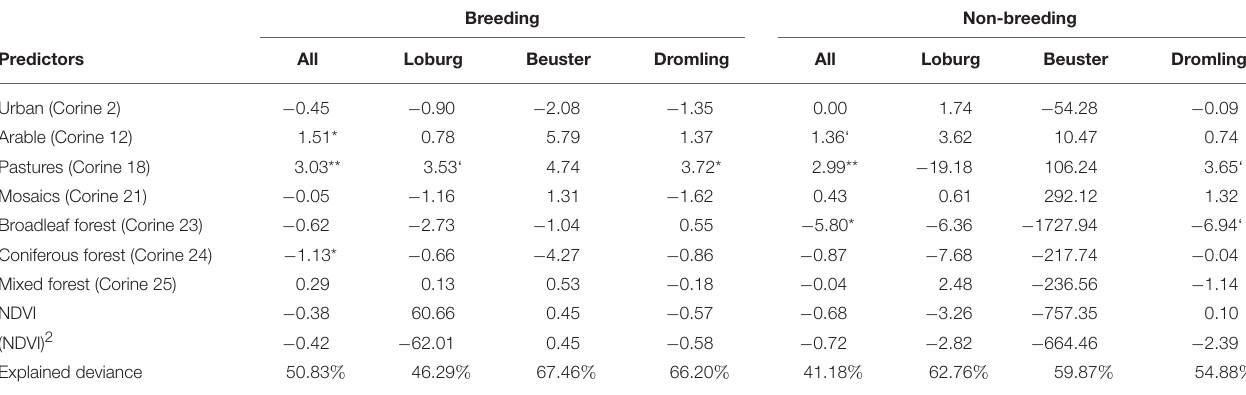
TABLE 3 | Home range selection models for breeding and non-breeding white storks.